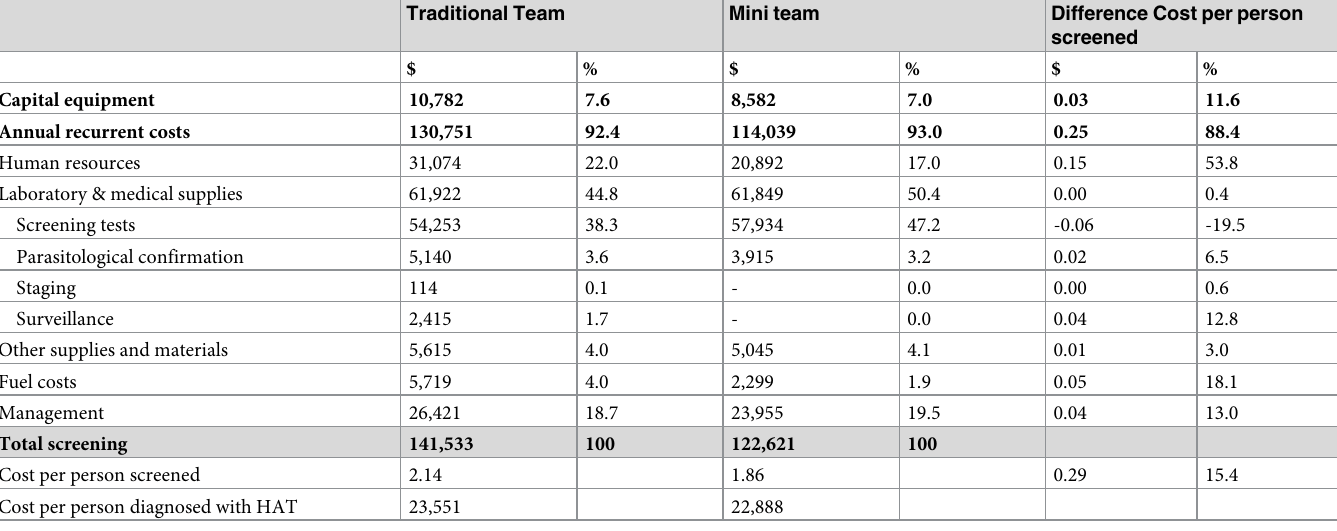
Table 5. Results scenario analysis: Costs of a traditional and mini team in an identical